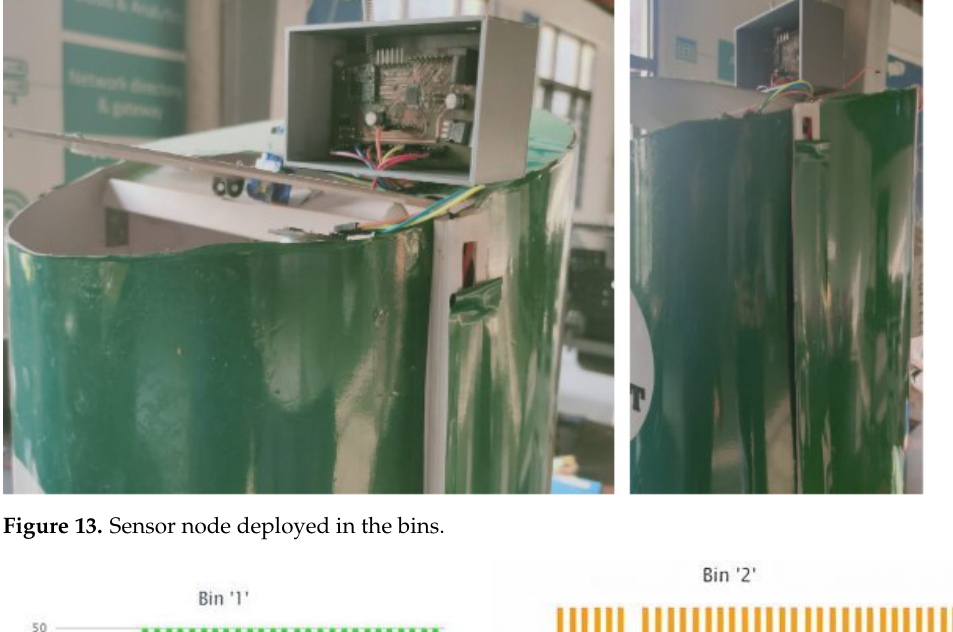
Figure 13. Sensor node deployed in the bins.